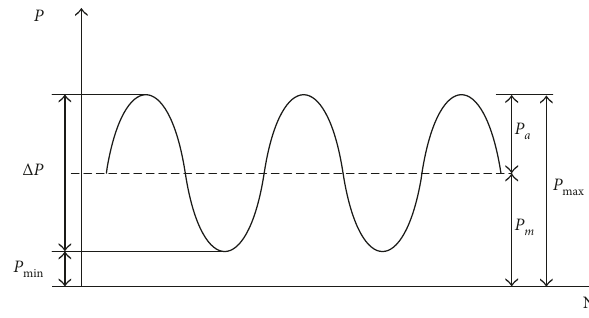
Figure 2: Relation among load parameters for the fatigue